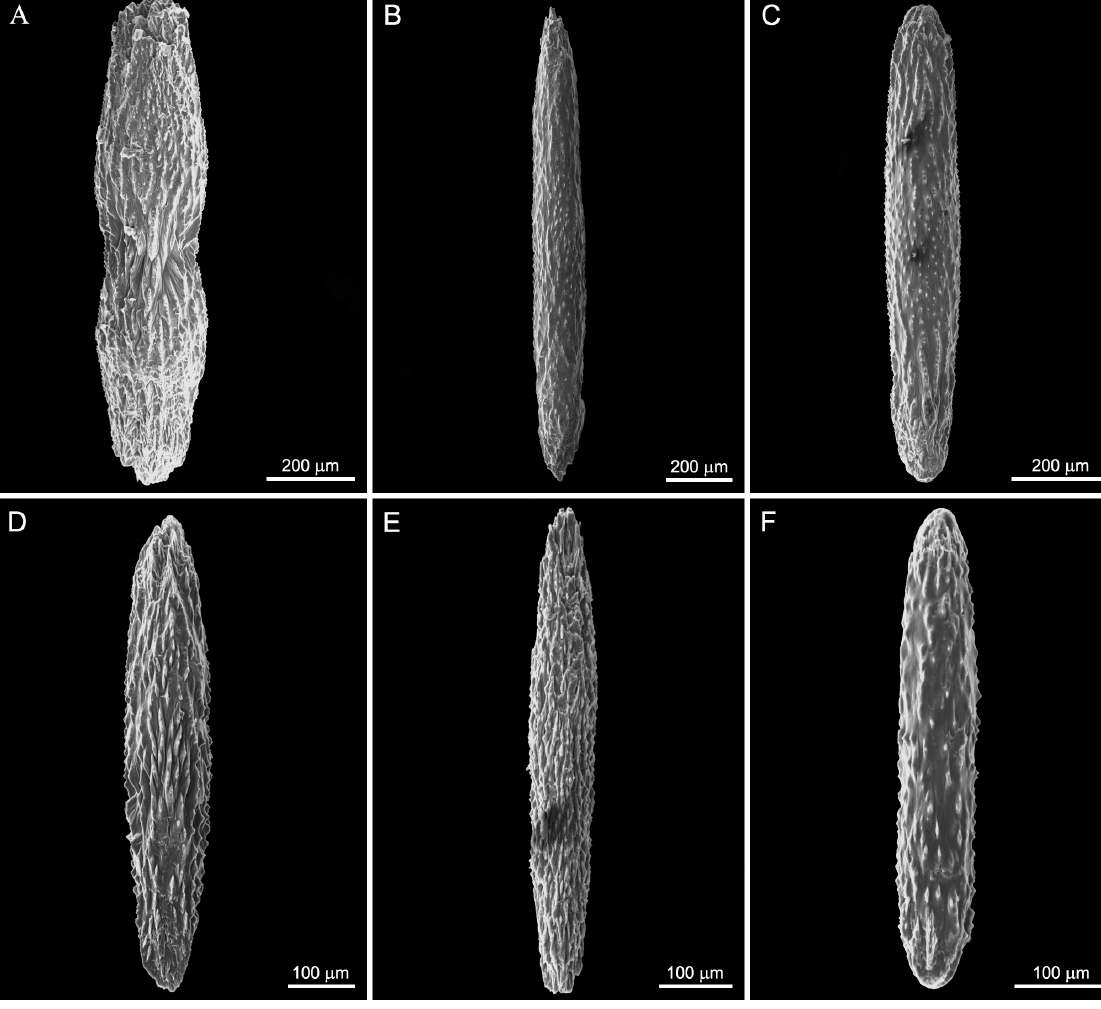
Fig. 6. Variability of sizes and ornamentations of the tentacles’ sclerites of the holotype of Umbellula pomona Risaro, Williams & Lauretta sp. nov. (MACN-IN